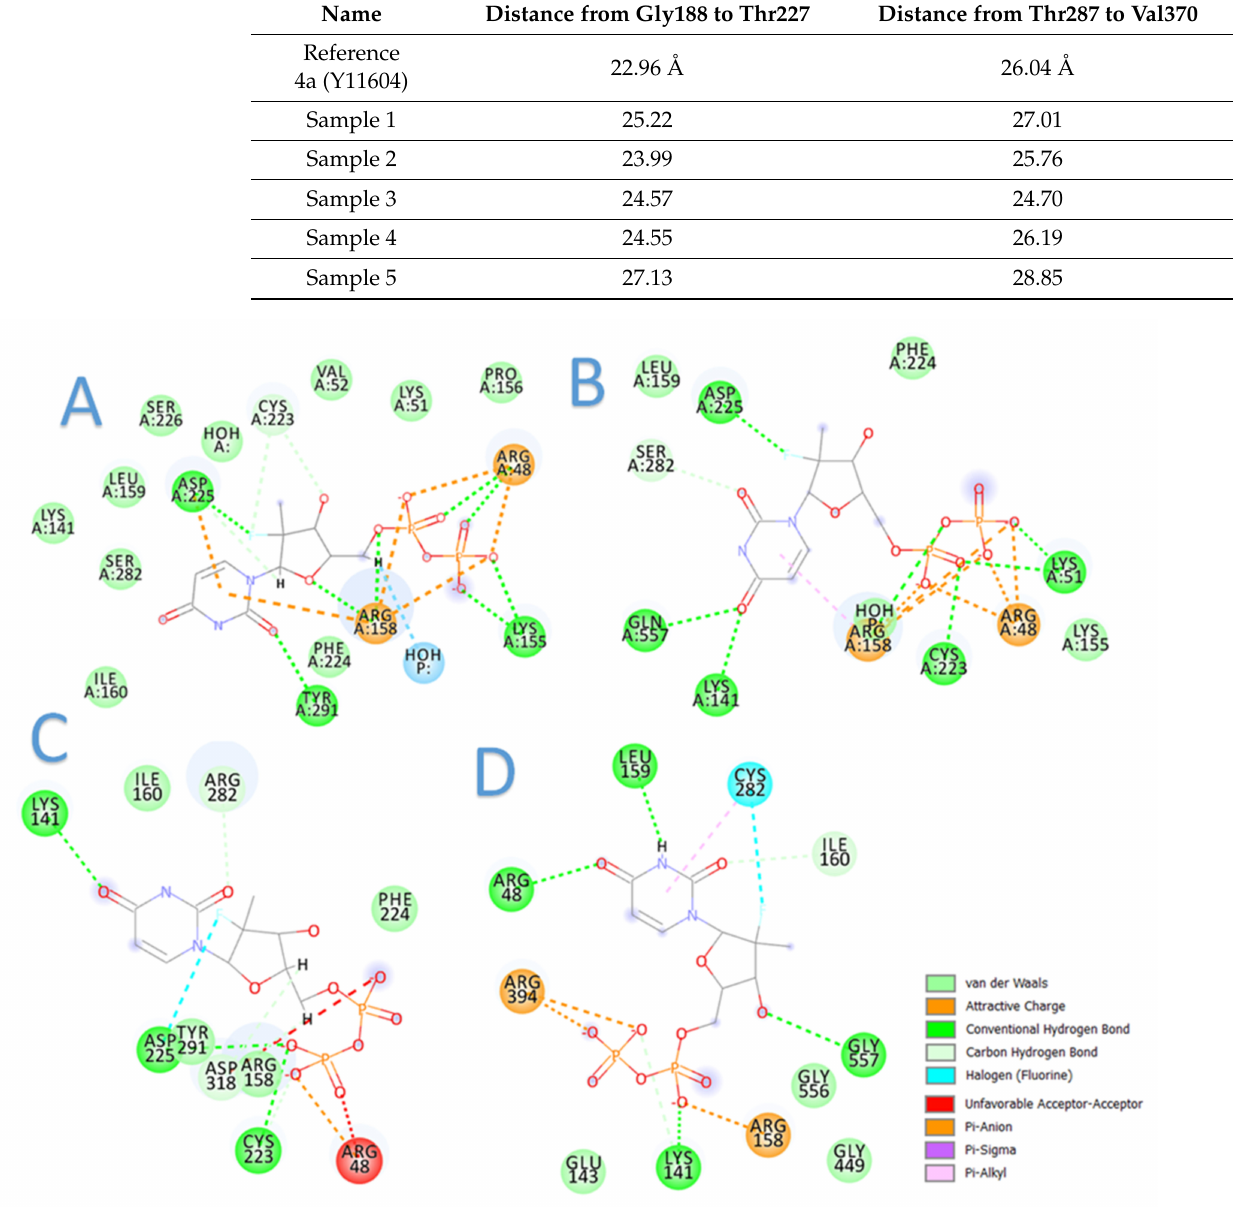
Table 5. Structural analysis and distances measured in each generated model.